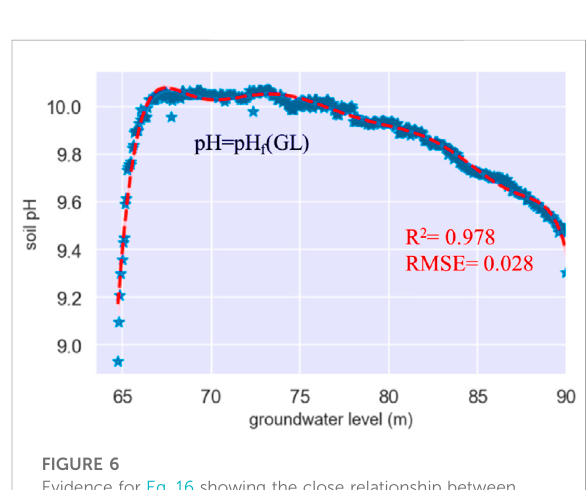
FIGURE 6 Evidence for Eq. 16 showing the close relationship between pH and groundwater level (GL) when GL varies from 65 to 90 m in irrigation seasons. Note: function h is an eighth-degree polynomial. The coef fi cients of the 8th, 7th, 6th, 5th, 4th, 3rd, 2nd, and 1st order terms are − 8.034e − 09, − 5.022e − 06,